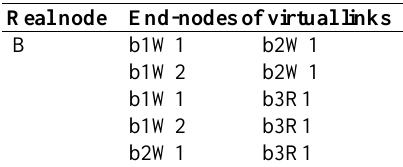
Table 3. Connecting virtual links to node b Real node End-nodes of virtual links